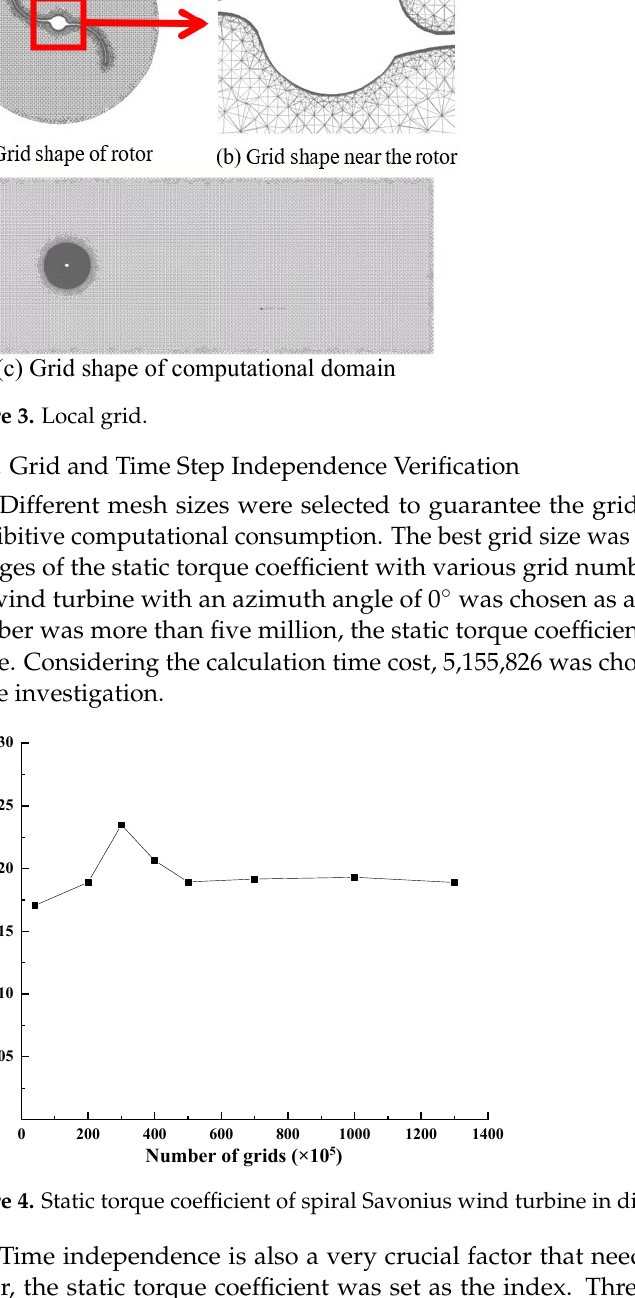
Figure 5. Time independence results. 2.2.5. Comparison between Wind Tunnel Test and Numerical Simulation To ensure the reliability of the simulation results, the static torque coefficient of the spiral Savonius wind turbine under an azimuth angle of 0°~180° obtained by numerical simulation was compared with the experiment results. As shown in Figure 6, the simula- tion results were basically consistent with the experimental results. In order to compare the differences between the simulation and experimental results, an analysis of variance was conducted, as presented in Table 2. The ANOVA results indicated that there was no significantly statistical difference between the experimental and simulation results ( p > 0.01). Therefore, it was considered feasible to use the simulation results. The maximum static torque coefficient was obtained when the azimuth was 50°. The experimental and 10.2